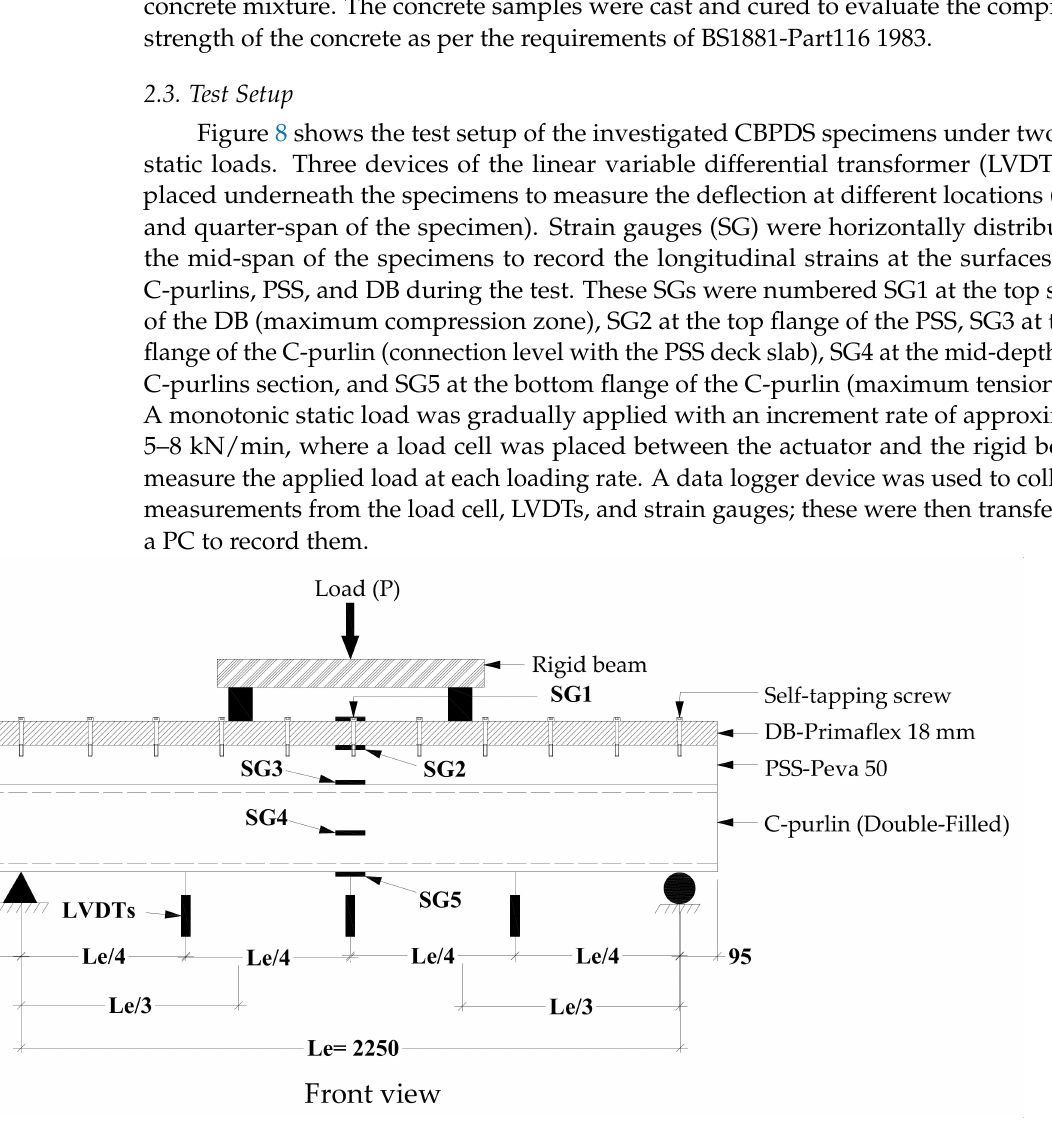
Figure 8. Schematic test setup of CBPDS specimens (all dimensions in